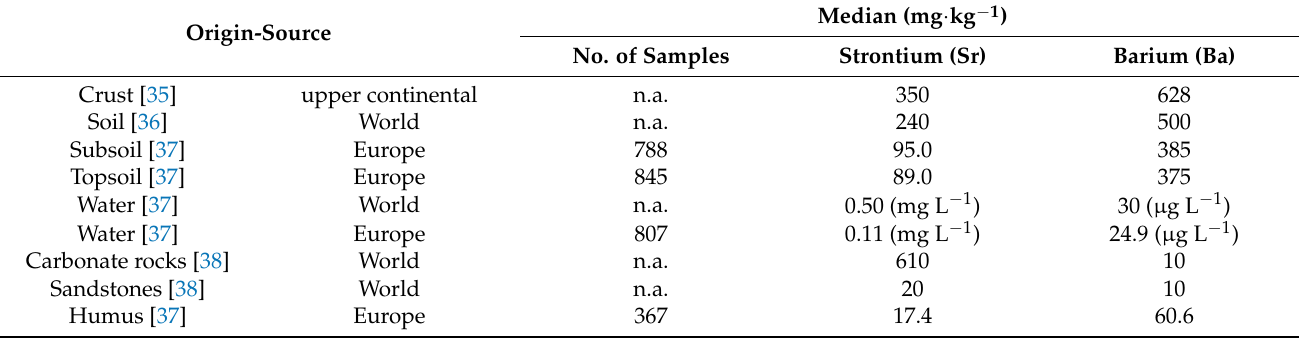
Table 1. Literature-based summary on the mean values of strontium and barium in the environment.